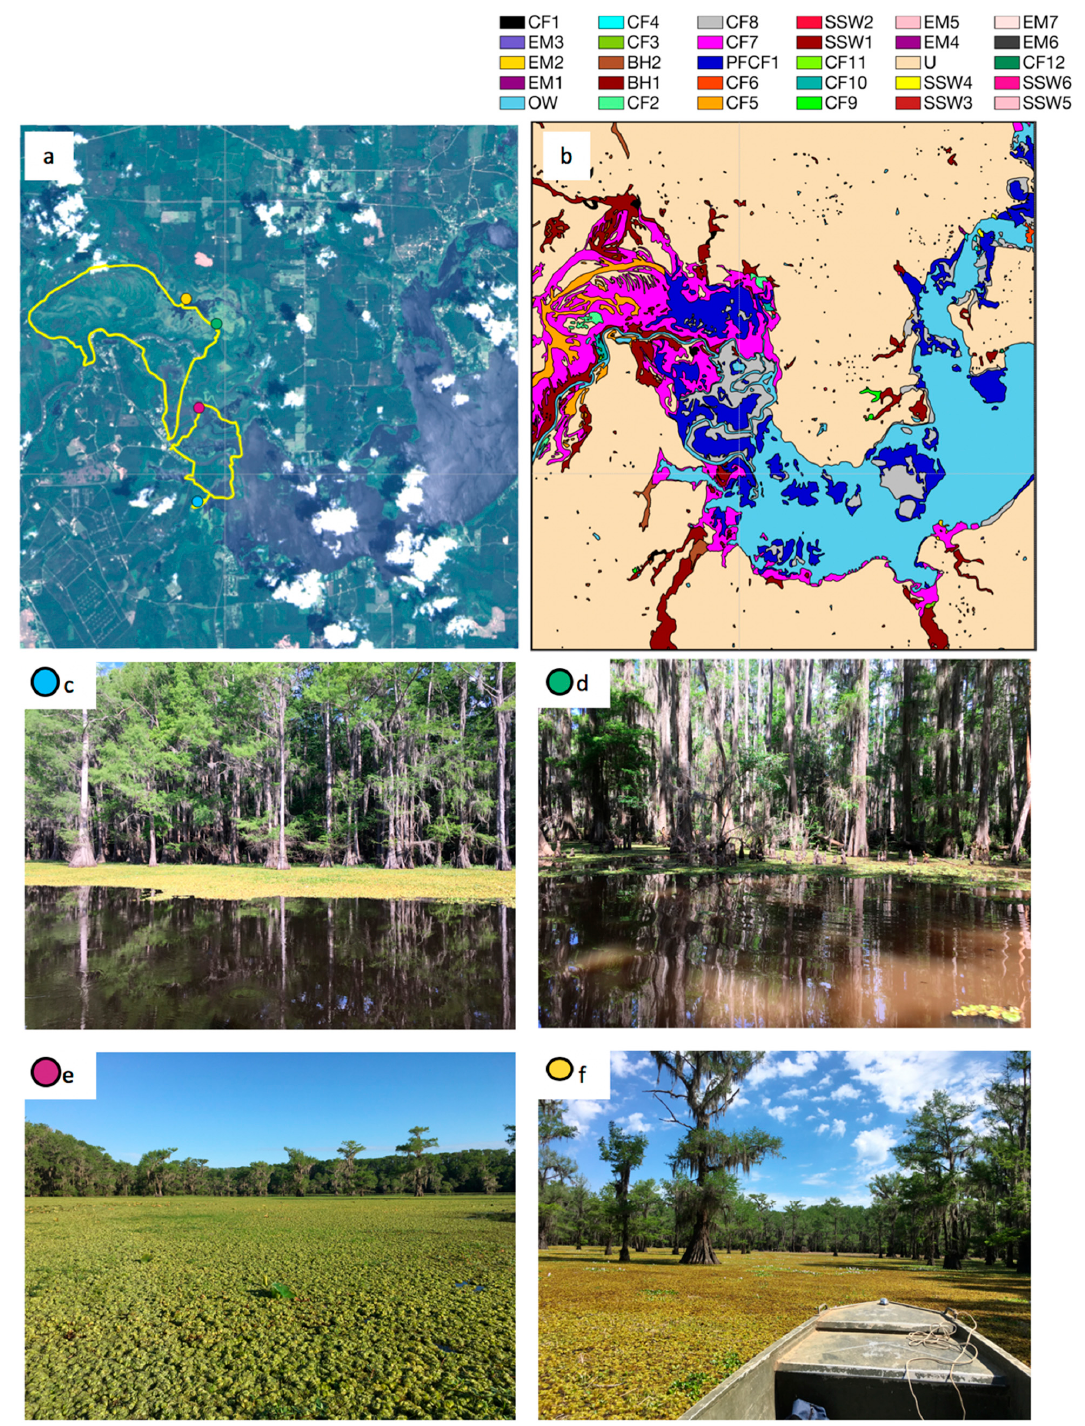
Figure 6. ( a ) Pansharpened Landsat 8 image of Caddo Lake from 8 May 2017. Yellow lines are GPS tracks of the boat. Colored dots are locations of photos in ( c – f ). ( b ). Landcover classification map of Caddo Lake [22]. Acronyms are defined in Table 1.